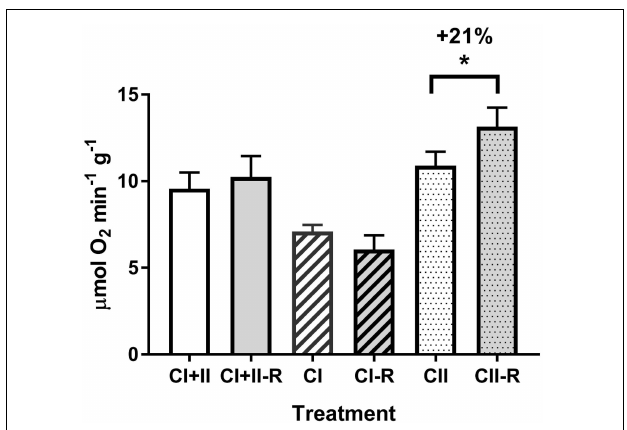
FIGURE 3 | Effect of hypoxia and reoxygenation (H/R) on the ETS activity of isolated digestive gland mitochondria of M. edulis respiring on different substrates. The percentage change following H/R stress was calculated by standardizing the control values at the respective temperatures to 100%. Significant differences in each mitochondrial trait between normoxia and reoxygenation are denoted by asterisks (* P < 0.05). CI - ETS activity with Complex I substrates (pyruvate and malate), CII - ETS activity with Complex II substrate (succinate), CI+II - ETS activity with pyruvate, malate and succinate. CI, CII, CI+II indicate control values before H/R stress, CI-R, CII-R and CI+II-R - the corresponding values after H/R